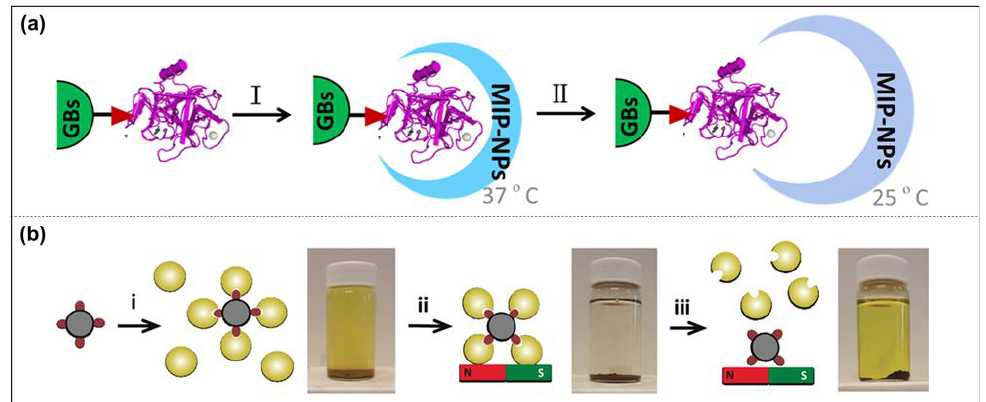
Figure 6. Schematic diagram of solid-phase synthesis of MIP-NPs on glass beads ( a ) and on magnetic beads ( b ). Reprinted with permission from Refs. [76,77]. Copyright 2016, ACS; 2019, Wiley.